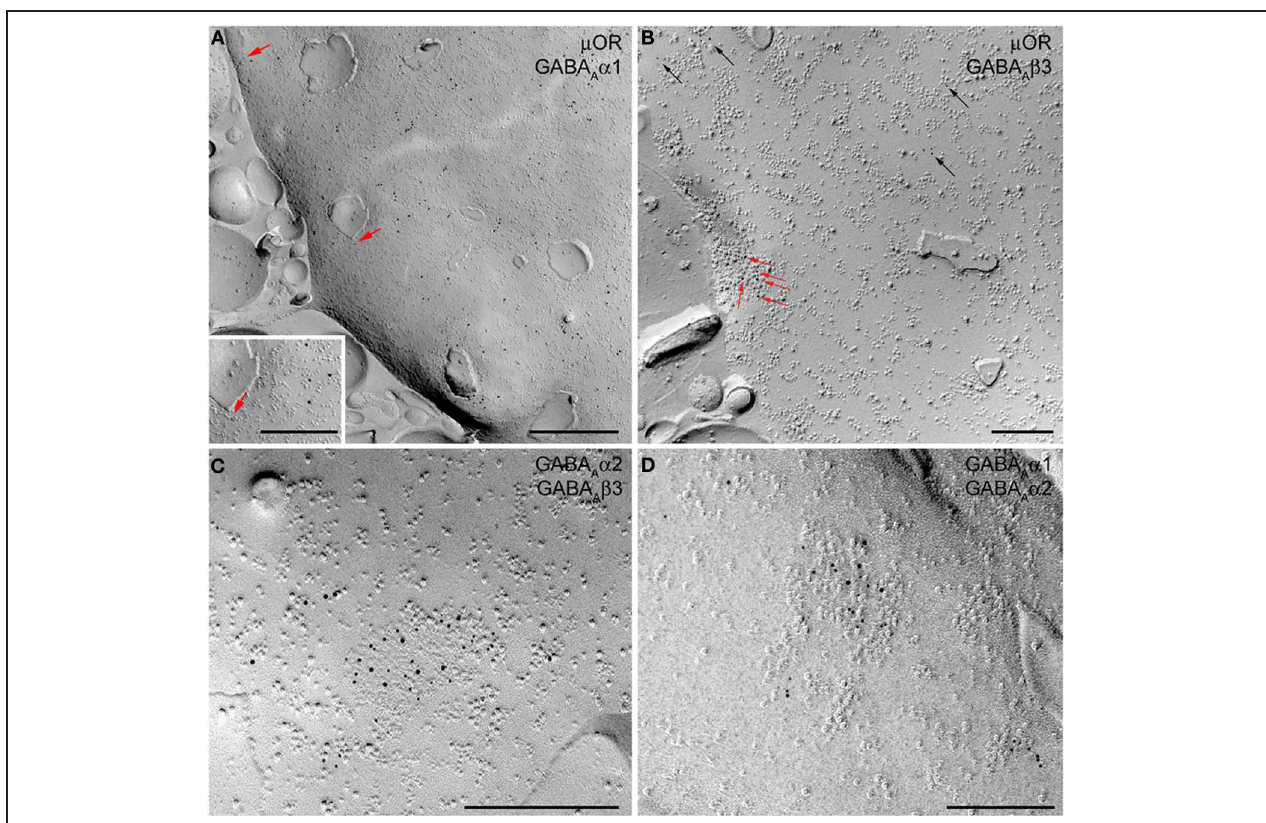
by red arrows) on a distinct cluster of intramembrane particles, and in the extrasynaptic area consistent with the lack or very low density of the α 1 subunit at Imp dendrites. Black arrows show immunogold particles for μ OR located in extrasynaptic areas. (C) Double labeling for α 2 (5nm) and β 3 (10nm) subunits showing their colocalization in a single GABAergic synapse of an Imp dendrite. (D) Double-labeling for α 1 (10nm) and α 2 (5nm) showing the colocalization of these two subunits in a GABAergic synapse of a pyramidal cell dendrite of the basal nucleus of the amygdala. Scale bars: A, 500nm; Insert, 250nm; B, − 500nm; C and D,